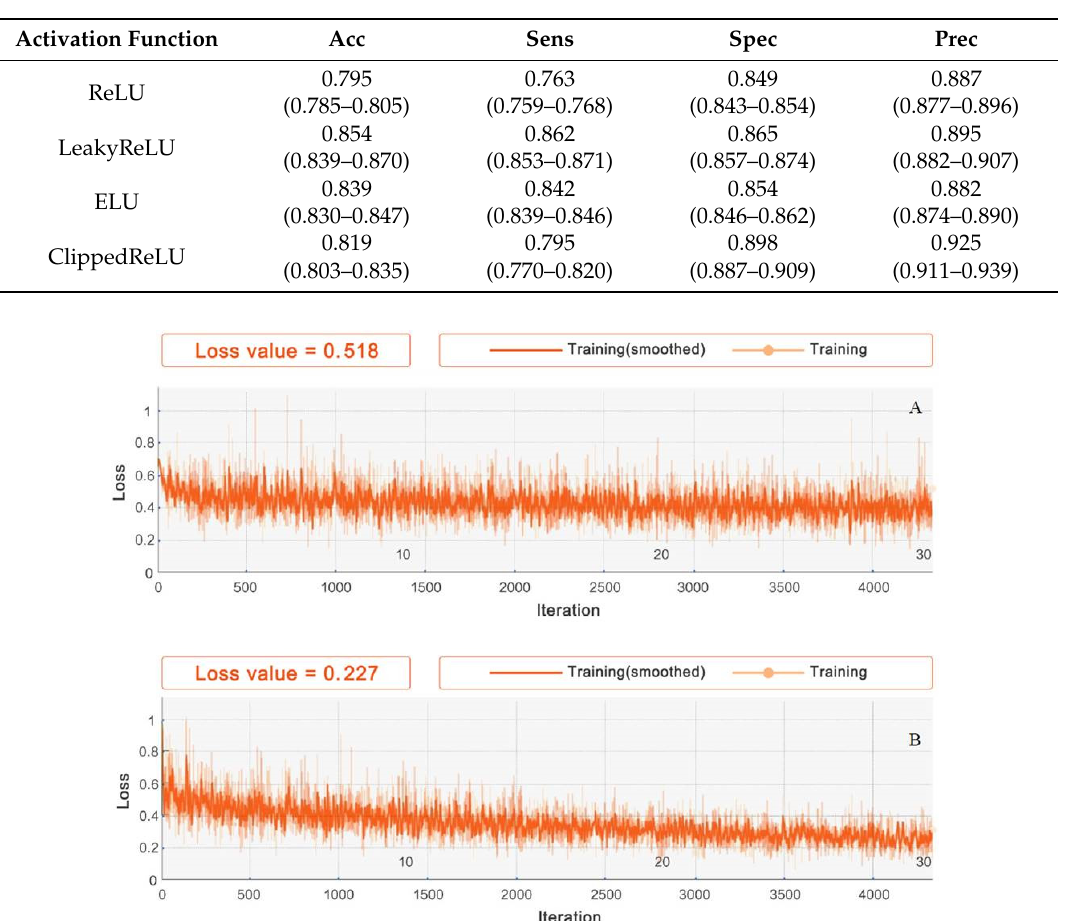
Table 4. Evaluation of IGRNet using various activation functions. The values represent the average values of the verification results and their 95% CIs.